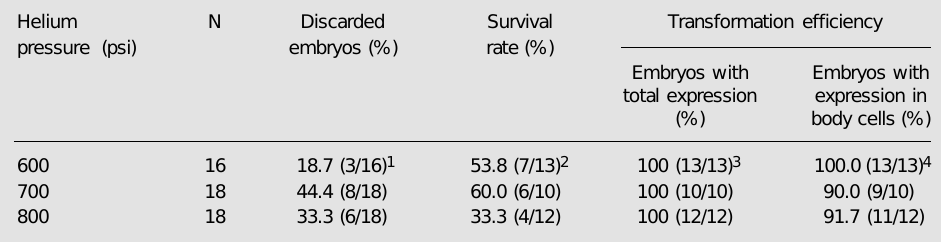
Table 3. Effect of helium pressure on percentage of discarded embryos, survival rate and ß-galactosidase (ß- gal) expression in embryos placed 0.5 cm from the center of the particle dispersion cone, using gold particles and 500 mmHg